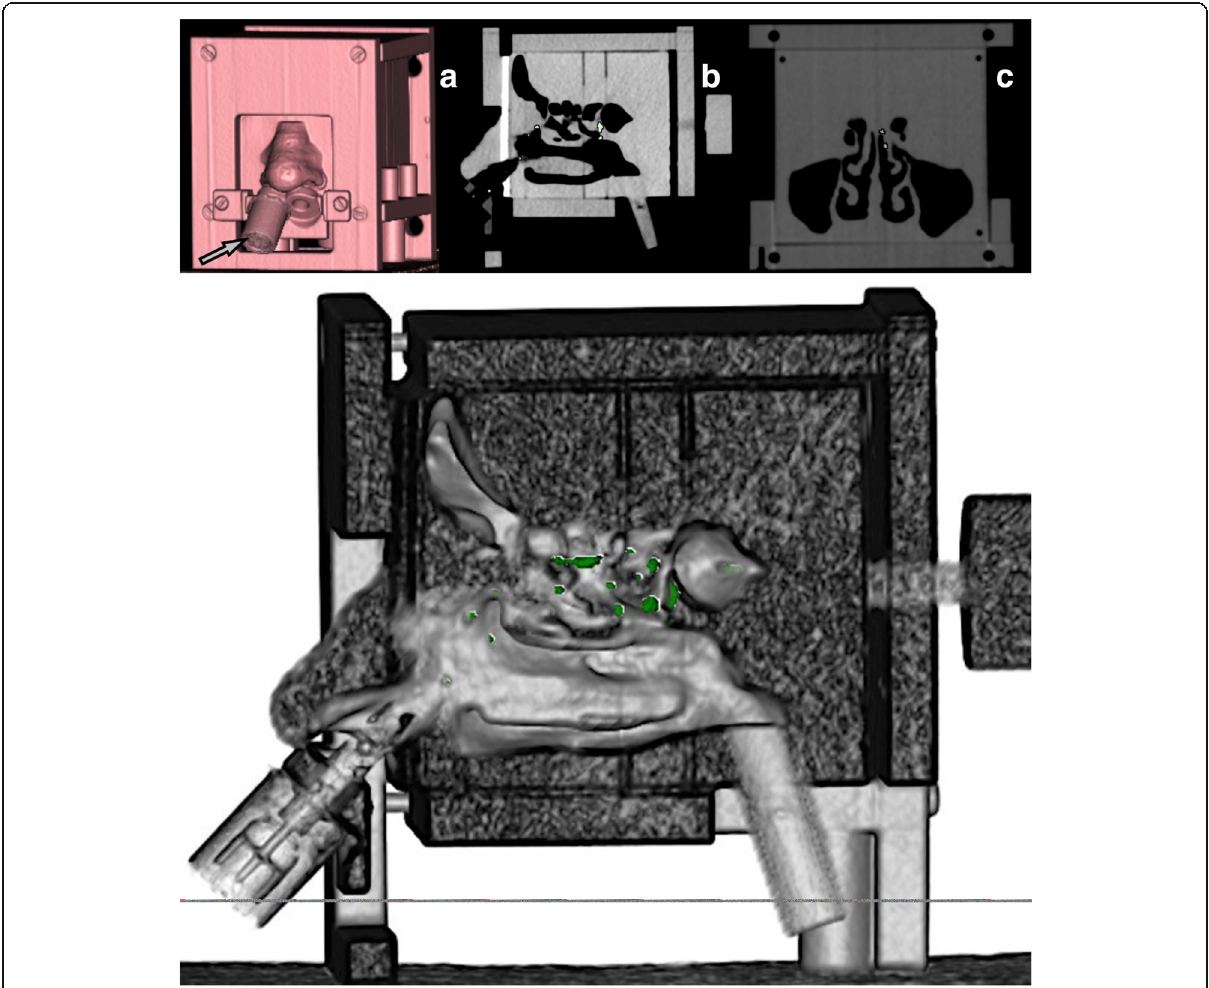
Fig. 1 Three-dimensional volume-rendered computed tomography image demonstrating the nasal cast from anteriorly: the nose spray (arrow) was applied into the support below the right nostril for standardised application of the spray ( a ). Sagittal reformation depicting the iodinated contrast agent droplets in the nasal cavity (bright hyperdense spots) ( b ). The colours indicate pixels with attenuation values exceeding the predefined threshold in the region of interest ( c ). On the lower image, a sagittal image after segmentation is shown. The green colour indicates the iodinated deposited droplets. Note the depositions mainly in regions next to the superior and middle